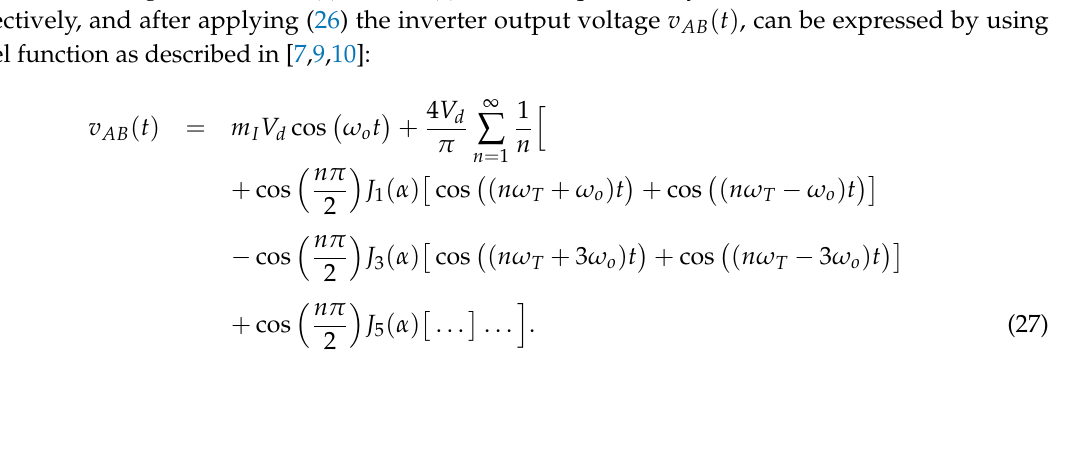
Figure 4. Modulator